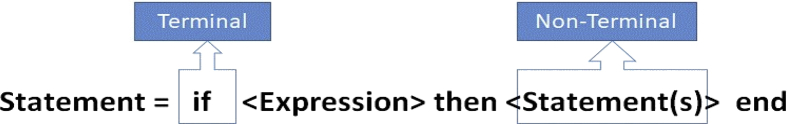
Parsing code into terminals and non-terminals.